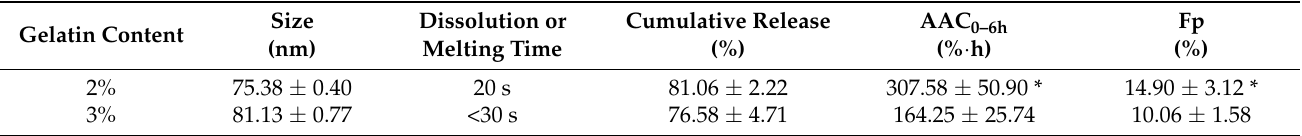
Table 1. Effect of gelatin content on appearance, size, dissolution time, AAC 0–6h , and Fp of IPC-DNV gels ( n = 3).